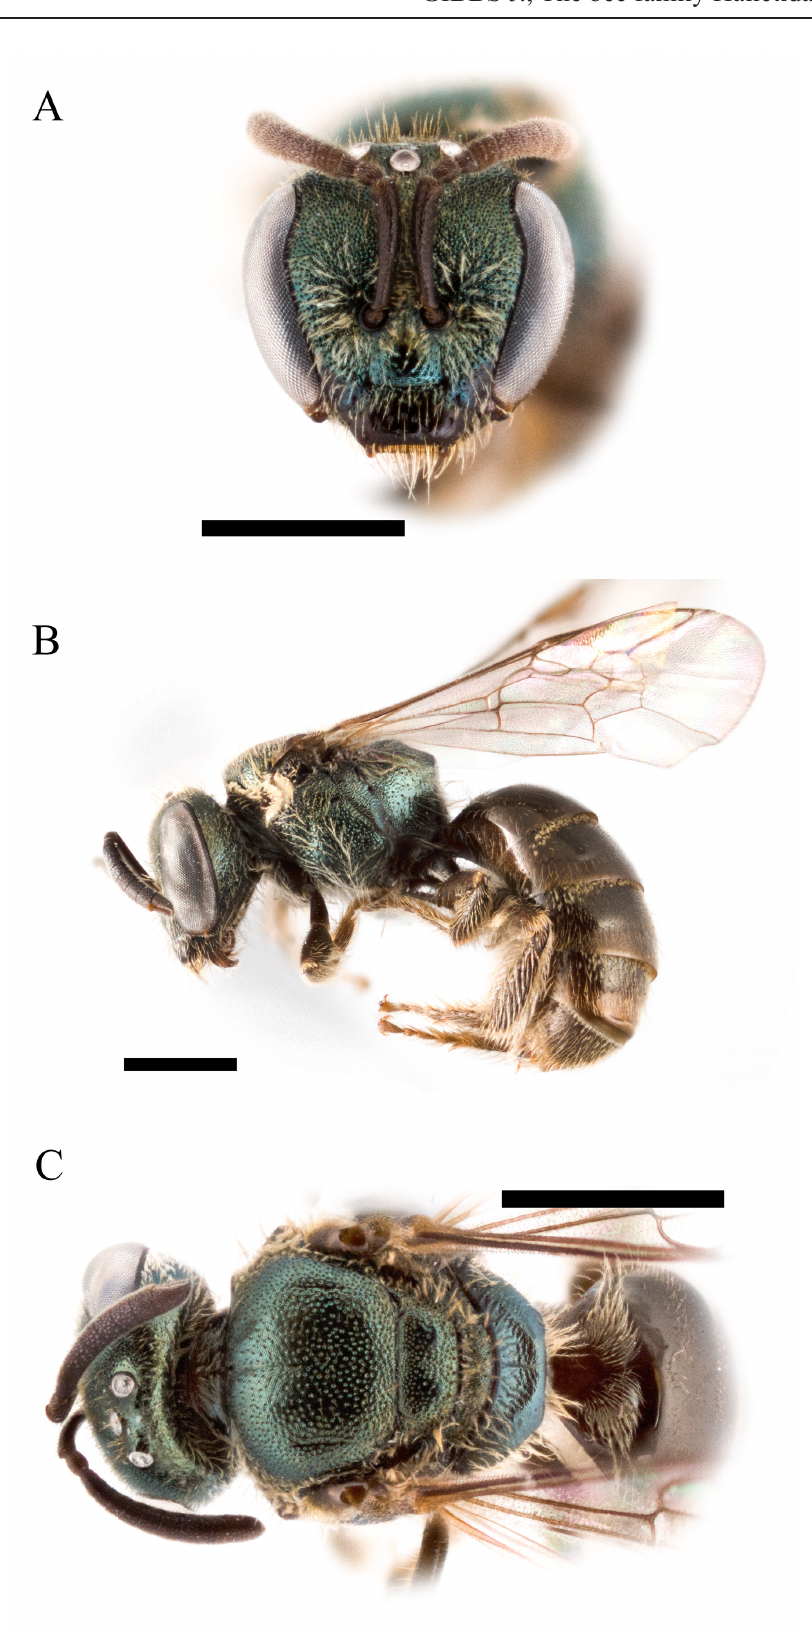
Fig. 2. Lasioglossum ( Dialictus ) dominicense sp. nov. Holotype (A, C) and paratype (B), ♀♀. A . Face. B . Lateral habitus. C . Dorsum of mesosoma. Scale bars = 1